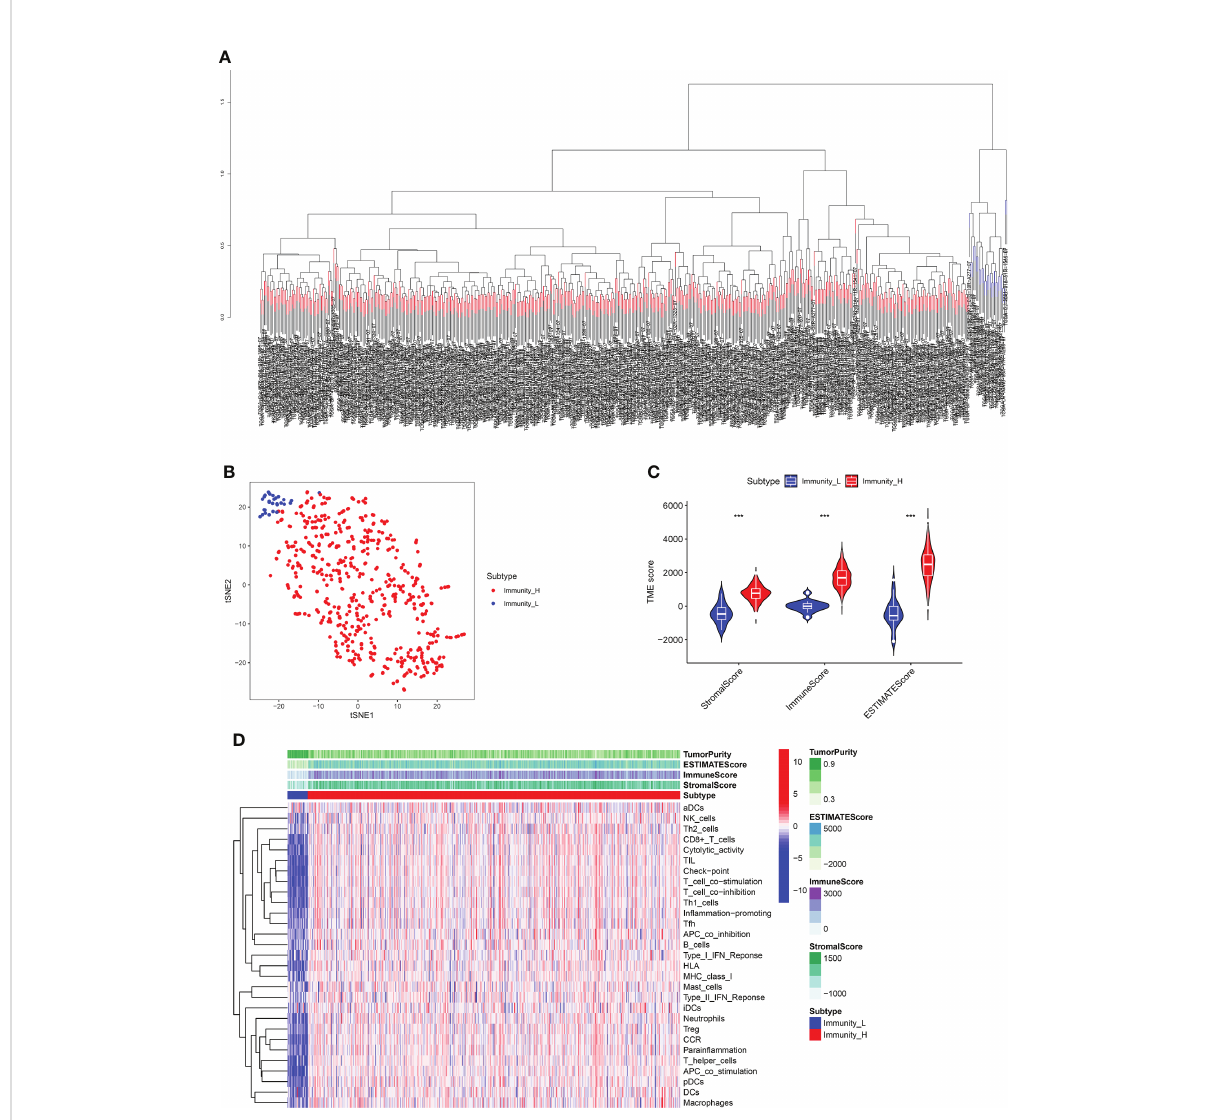
FIGURE 1 (A) The ssGSEA method cluster the TCGA dataset containing RCC samples based on the expression pro fi les of the immune cells. (B) Dimensionality reduction algorithm t-SNE showed that the subtypes were highly consistent with two-dimensional t-SNE distribution patterns. (C) TMB score analysis between immune_H and immune_L groups. (D) The heatmap demonstrated the different expression level of immune cells between immune_H and immune_L groups *** P <